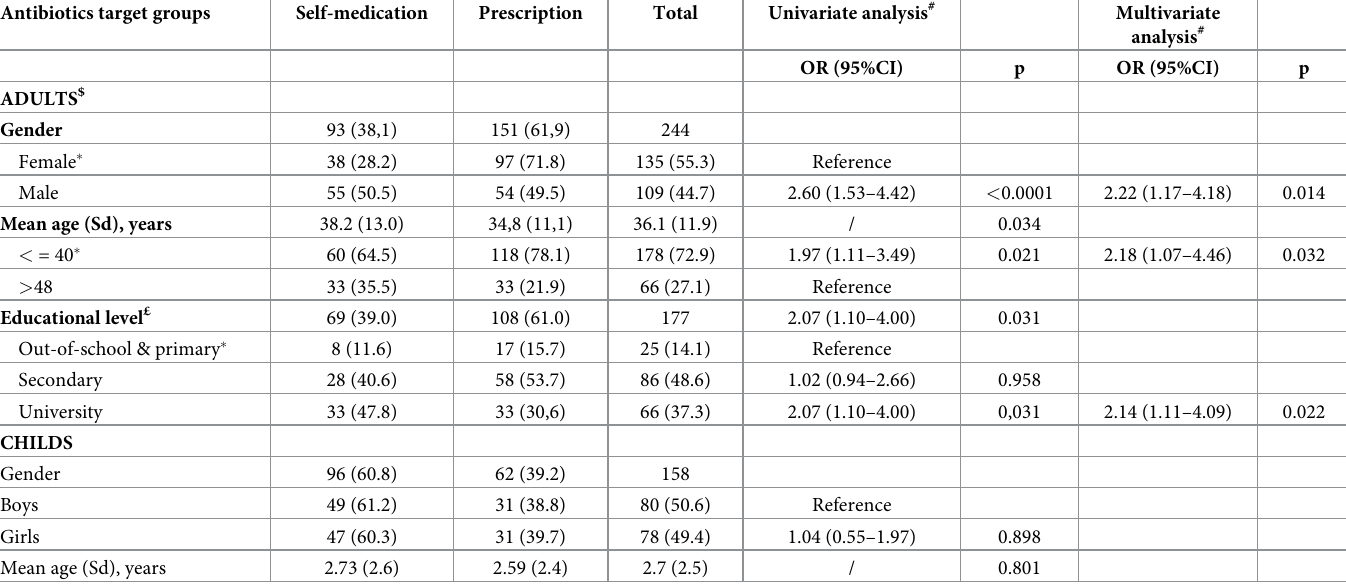
Table 5. Multivariate analysis of factors associated with type of medication according to antibiotic target